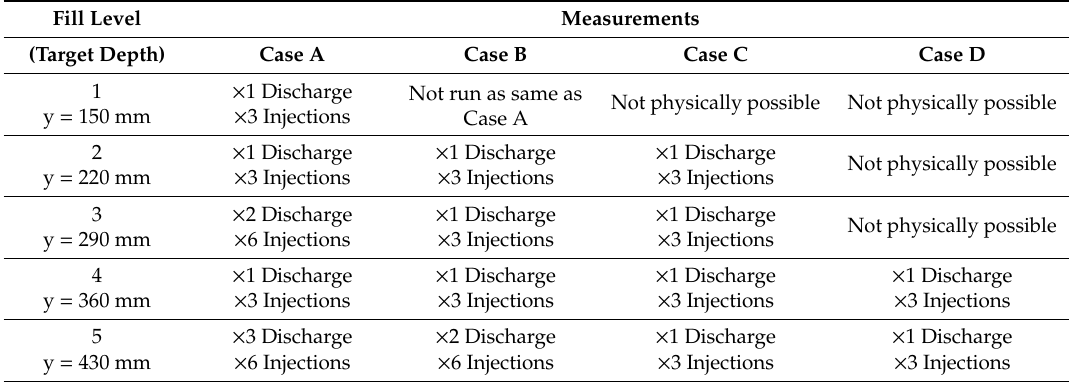
Table 1. Test program (fill levels are target